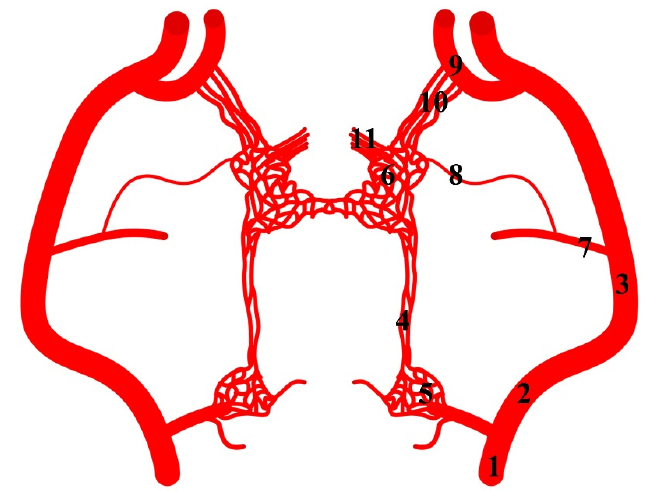
Figure 8. Diagram of the arterial pattern in the common hippopotamus. 1—common carotid artery;